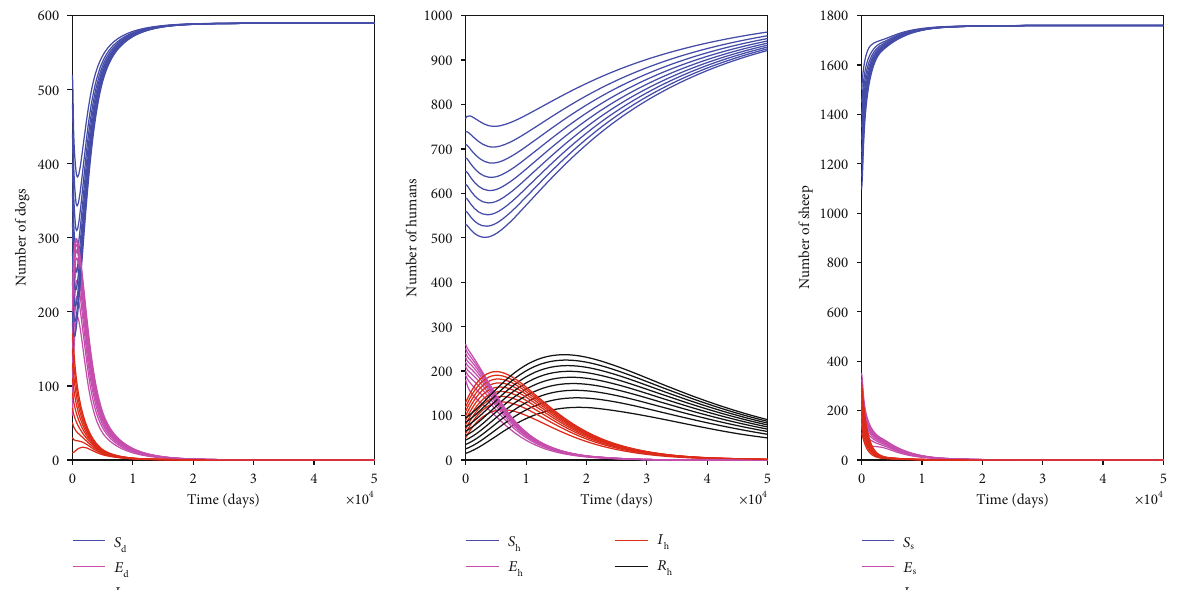
Figure 3: Time evolution of the dog, sheep, and human populations with baseline parameter values given in Table 3, using di ff erent initial conditions, which gives R = 0 : 57 . 0